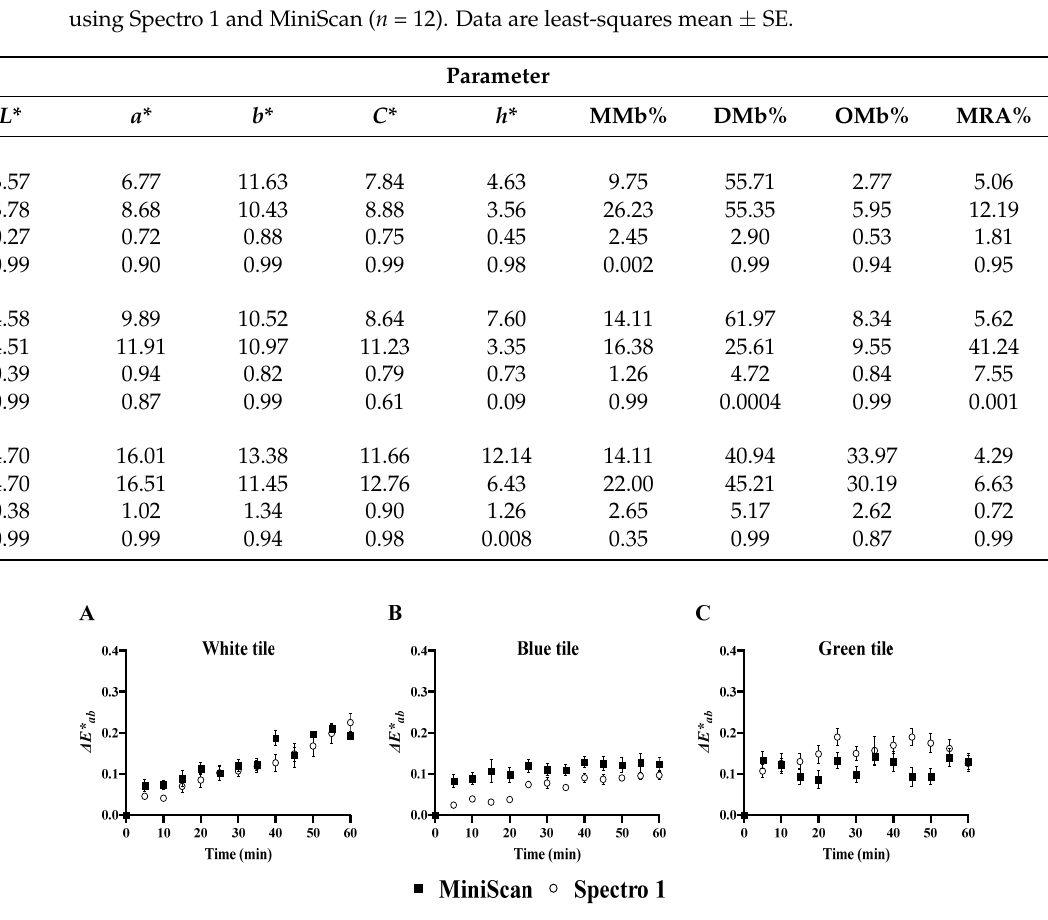
Figure 7. Scatter plots of total color difference over time ( ∆ E * ab ) for Spectro 1 and MiniScan. Measurements were collected on three different calibration tiles: white tile ( A ), blue tile ( B ), and green tile ( C ). Values are expressed as the difference in color values at each time point to measurement taken at 0 min. Table 2. Coefficient of variation (CV) for lightness ( L *), redness ( a *), and yellowness ( b *) obtained from white, blue, and green calibration tiles over a 60-min period using Spectro 1 and MiniScan ( n = 12). Data are least-squares mean ± SE.